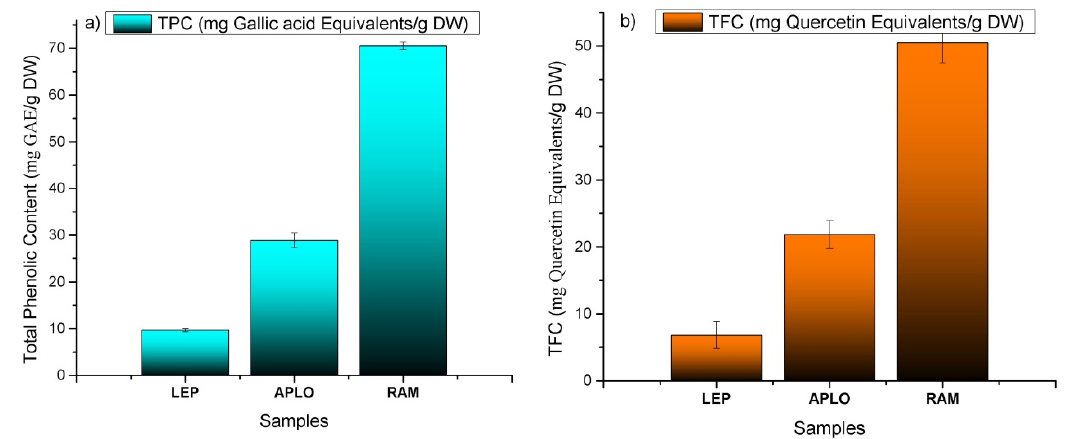
Figure 8. ( a ) Total phenol content (TPC) and ( b ) total flavonoid content (TFC) of Nolana leptophylla (LEP), N. aplocaryoides (APLO) and N. ramosissima (RAM) collected in Paposo Valley, II region of